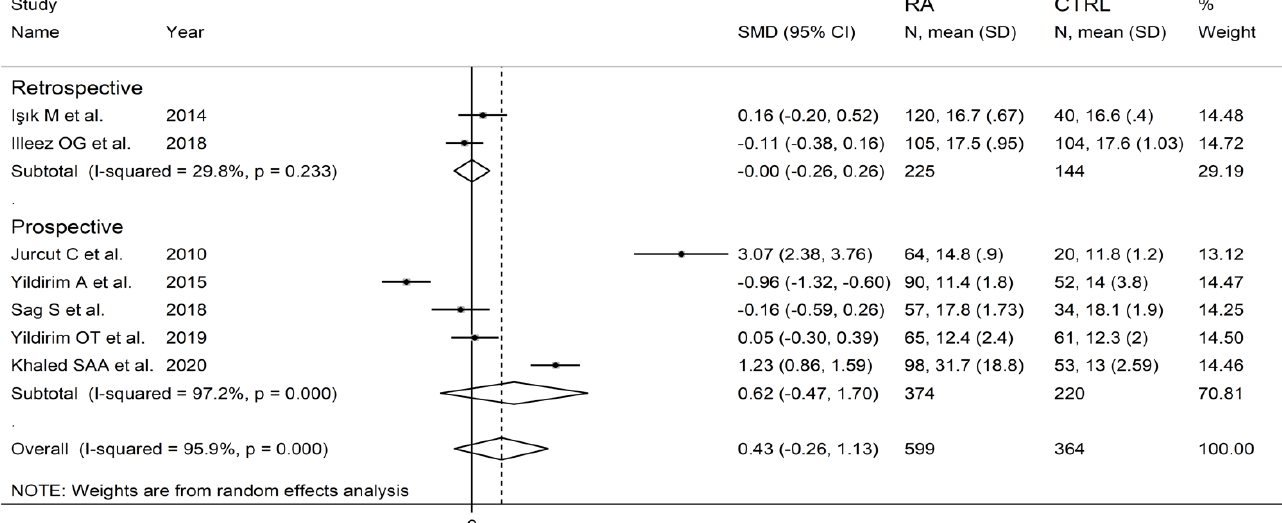
Figure 10. Forest plot of studies examining the platelet distribution width in patients with rheumatoid arthritis and healthy controls according to study design.